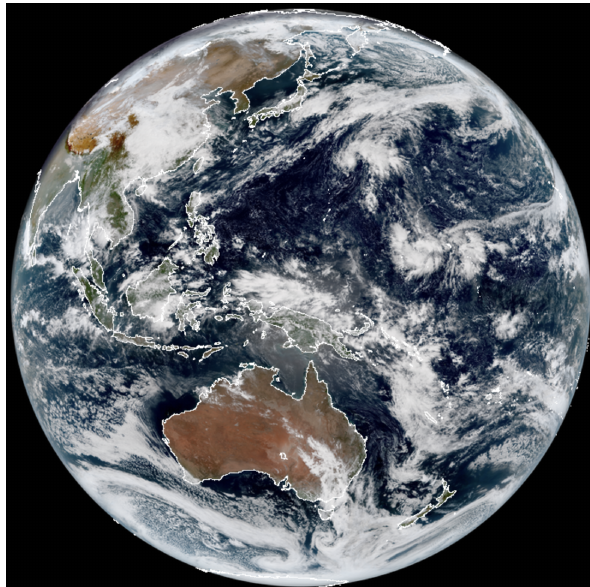
Figure 1. Full-disk true color image from AHI using the 0.64, 0.51, and 0.47µm channels. The image was taken on 20 Octo- ber 2018 at 02:10UTC. The image is created using following tool: https://rammb-slider.cira.colostate.edu/?sat=himawari, and it has been obtained from the Himawari-8 slider hosted by Colorado State University, which can be accessed at https://rammb-slider.cira. colostate.edu/?sat=himawari.